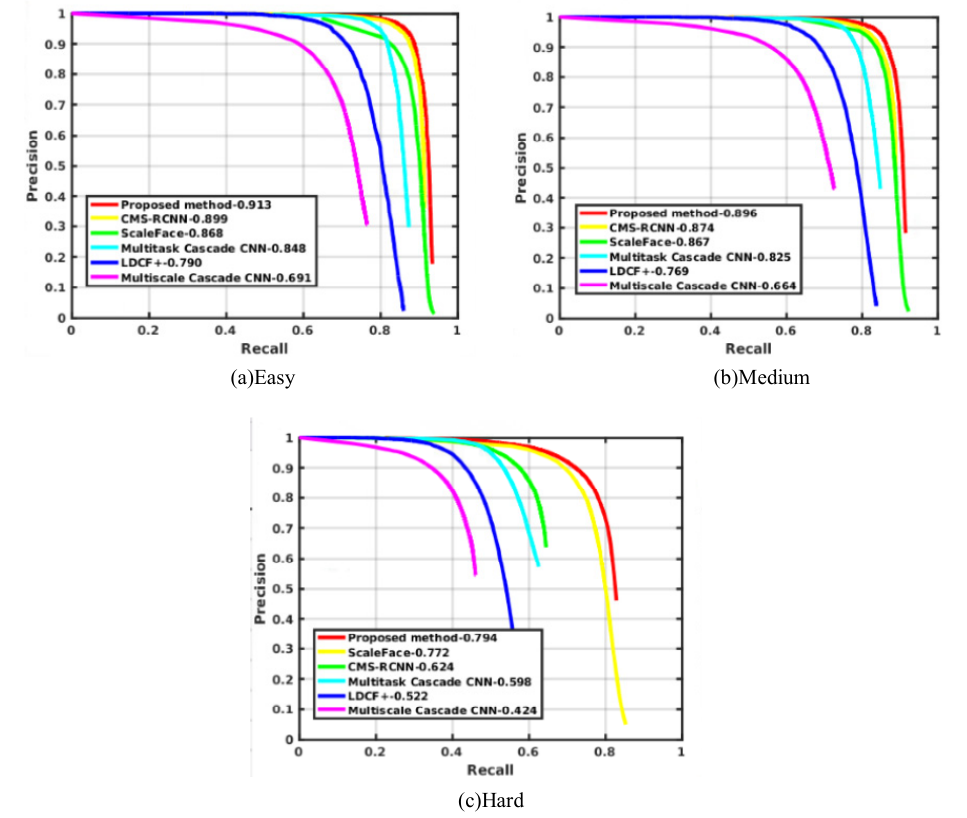
Figure 9. PR curves of the proposed method and typical face detection methods.